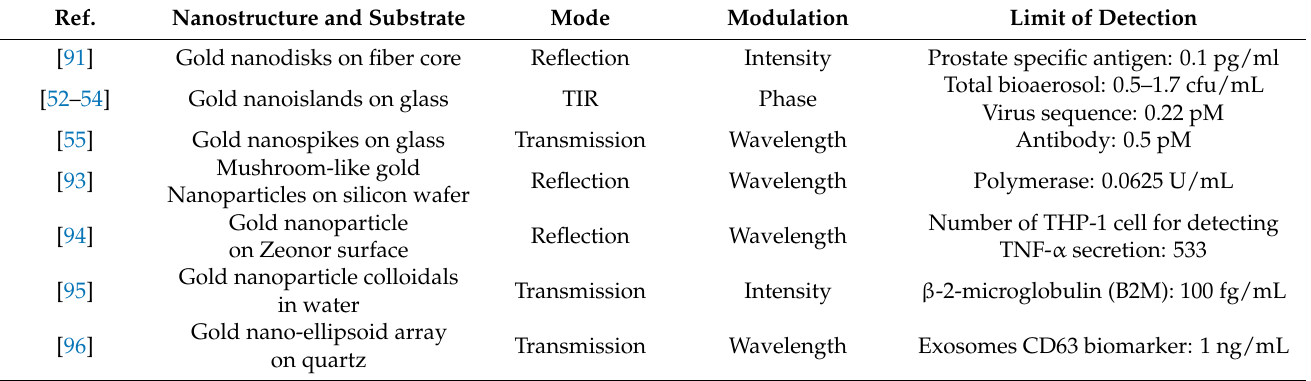
Table 4. Comparison of LSPR configuration and sensing